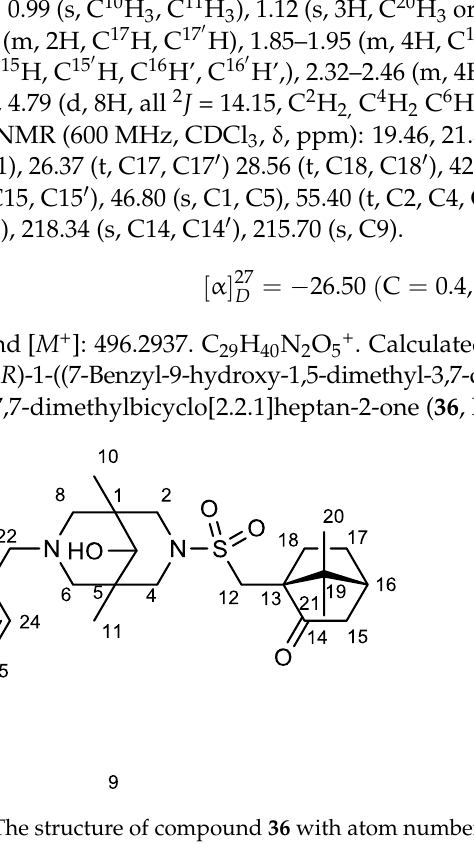
Figure 1. The structure of compound 35 with atom numbering scheme. To a mixture of 216 mg (1.2 mmol) diazaadamantane 18 and 202 mg (2.4 mmol) of NaHCO 3 in 14 mL of benzene and 4 mL of water was added 482 mg (2.4 mmol) of acid chloride 34 in 2 mL of benzene for 10 min. The mixture was allowed to stand for 6 h. The aqueous phase was separated, washed with benzene; the organic phases were combined, the solvent was evaporated. After chromatographic column 240 mg of the product (80%) were isolated. 1 H NMR (600 MHz, CDCl 3 , δ, ppm, J , Hz; for the numbering of the atoms, see Figure 1): 0.99 (s, C 10 H 3 , C 11 H 3 ), 1.12 (s, 3H, C 20 H 3 or C 21 H 3 ), 1.20 (s, 3H, C 20 H 3 or C 21 H 3 ),